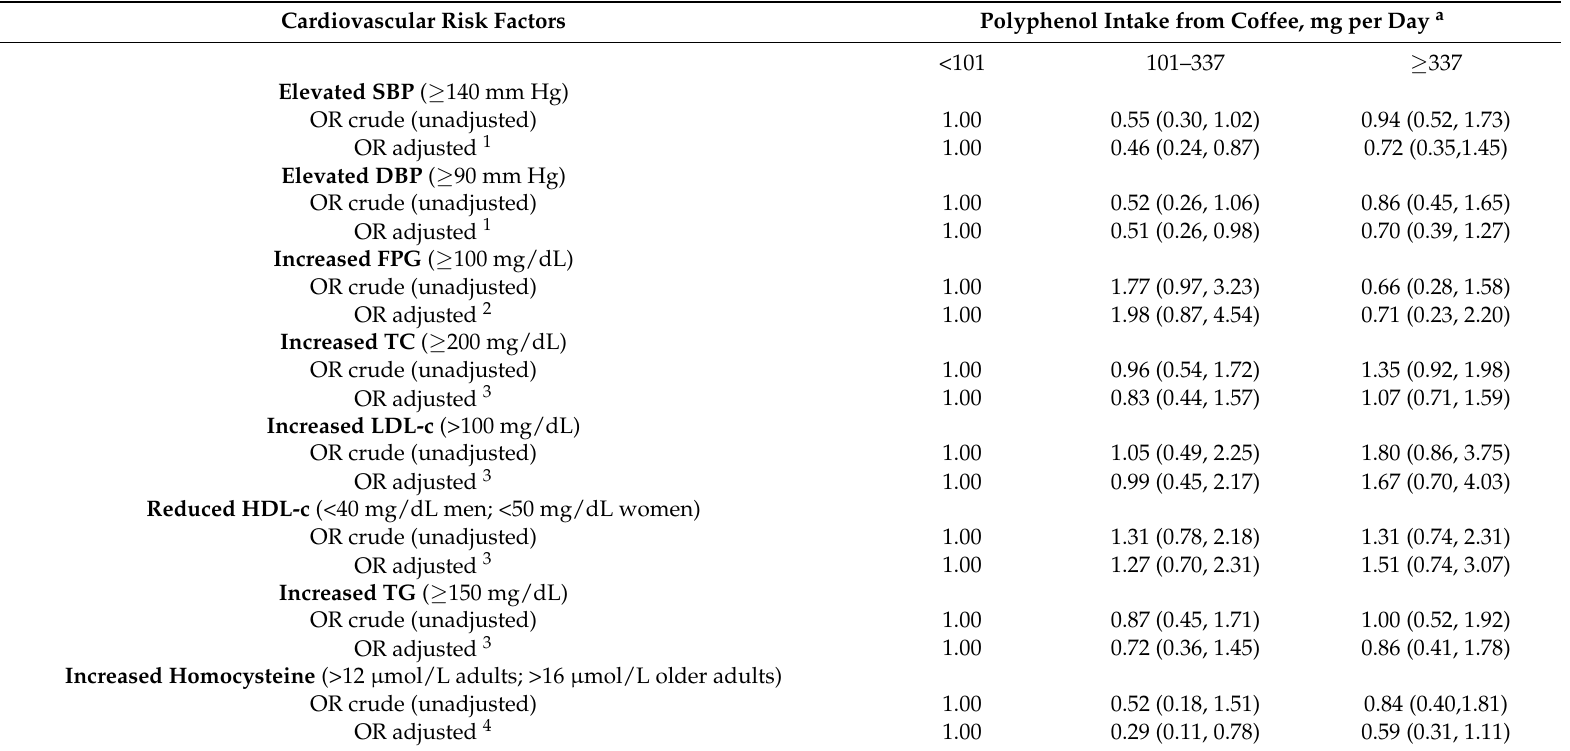
Table 3. Association between cardiovascular risk factors and categories of coffee polyphenol intake in Health Survey of S ã o Paulo (ISA-Capital) population. S ã o Paulo, Brazil,